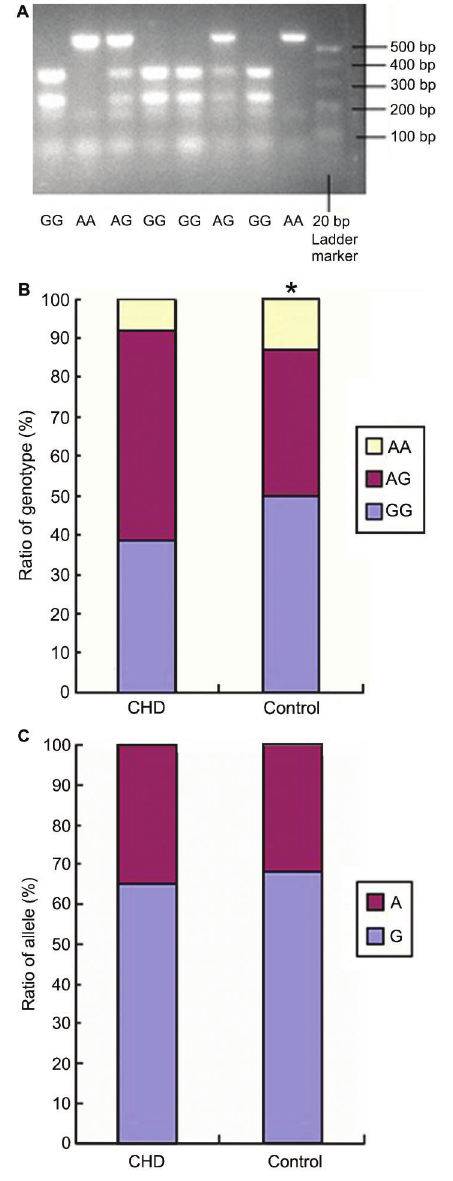
Figure 2. Distribution of genotypes and alleles of rs1761667 between coronary artery heart disease (CHD) patients and healthy controls. A , There are three genotypes of rs1761667 in the chipping fragments displayed by RFLP analysis: AA (595 bp), GG (362++233 bp) and AG (595++362++233 bp). B , The frequencies of three kinds of genotypes (GG, AG, AA) of rs1761667 in the CHD group and control group were 38.39, 53.57, 8.04%, and 49.61, 37.21, 13.18%, respectively. The distribution of genotypes in the CHD group and control group had a significant difference (*P=0.034), with the frequency of AG genotype significantlyhigherintheCHDgroupthaninthecontrolgroup(P=0.011). C , The frequencies of G/A alleles of rs1761667 in the CHD group and control group were 65.18, 34.82, and 68.22, 31.78%, respectively. No significant difference in the distributions of G/A allele frequencies was observed between the two groups (P=0.480). The x 2 test was used for statistical analyses.